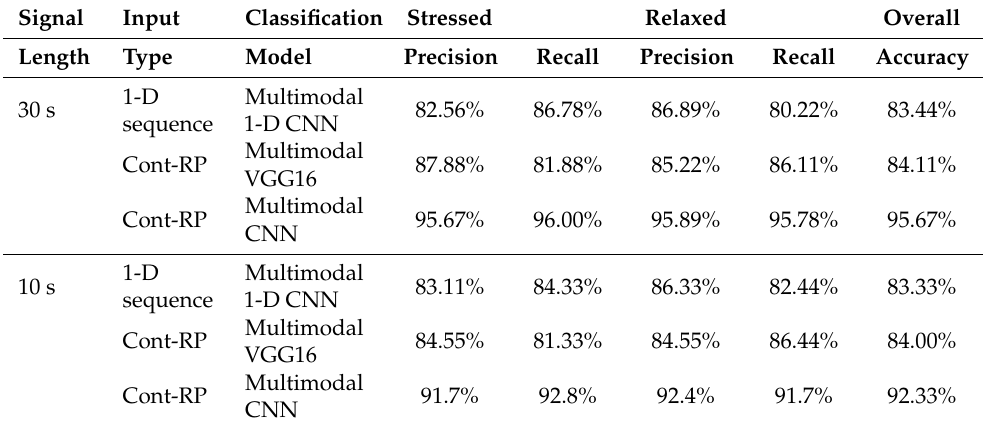
Table 6. Classification performance of proposed method compared with baseline CNN